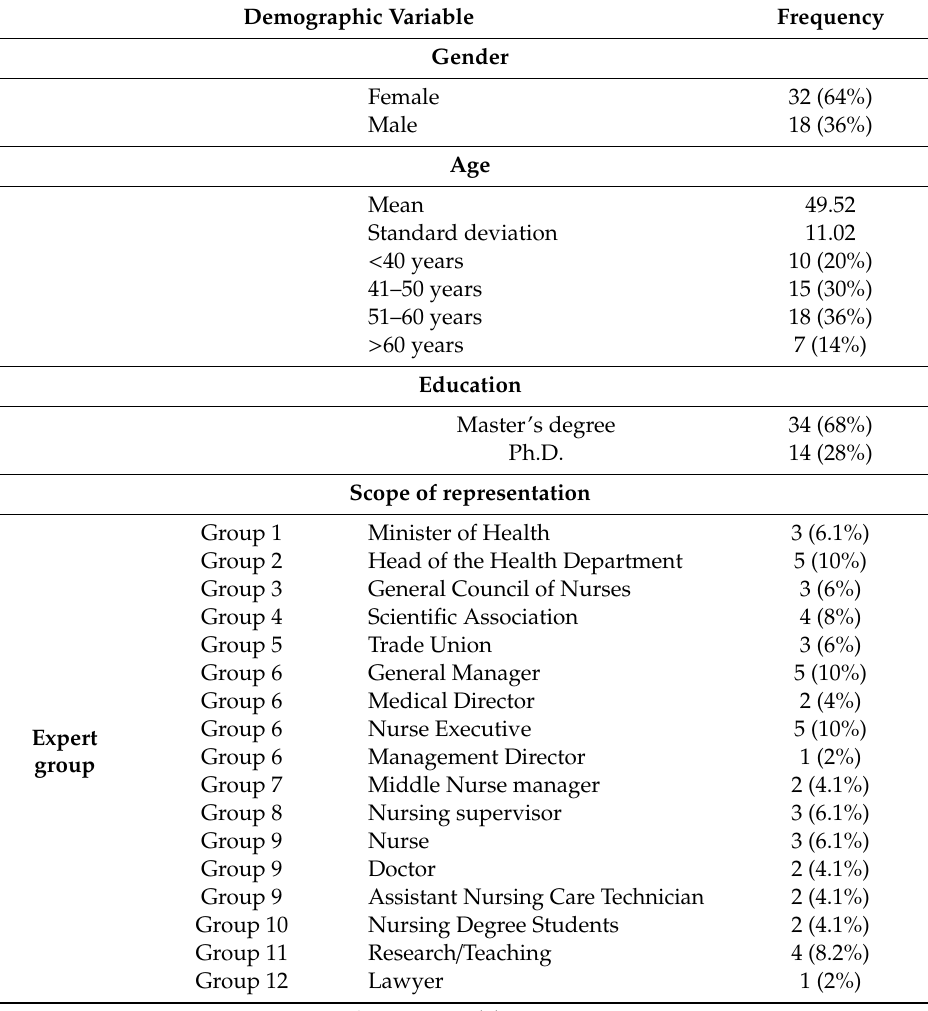
Table 1. Socio-demographic data from the panel of